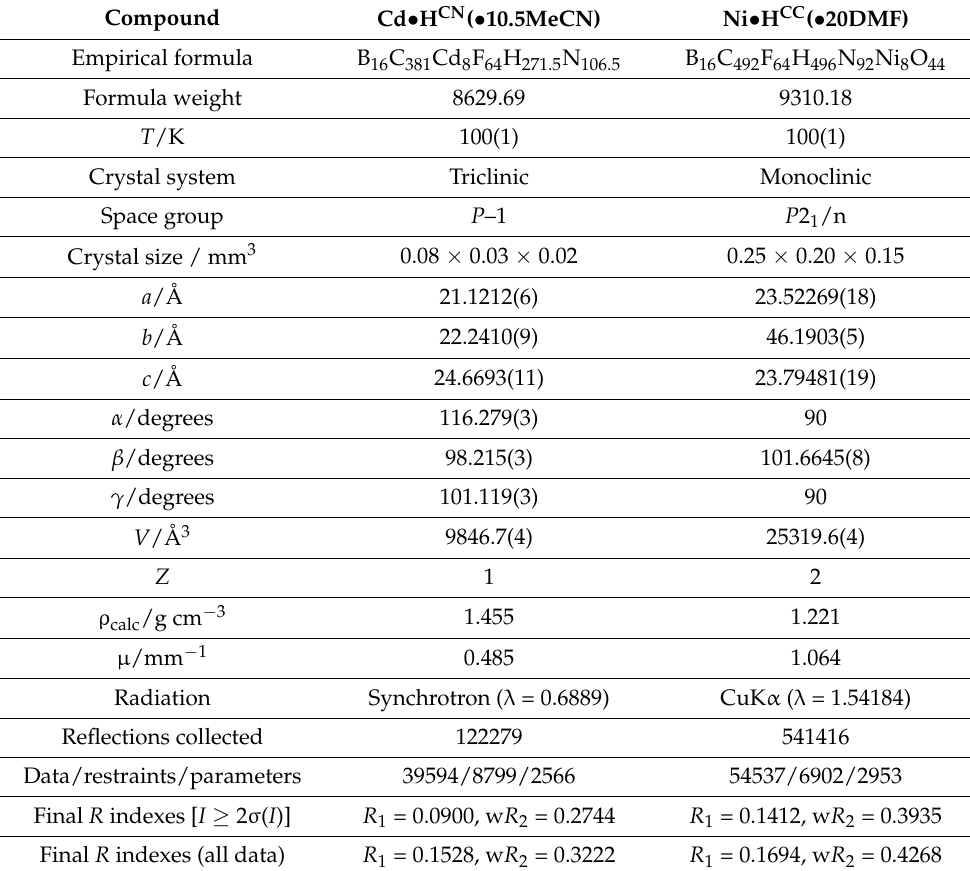
Table 1. Summary of crystallographic, data collection and refinement parameters for the two crystal structures in this